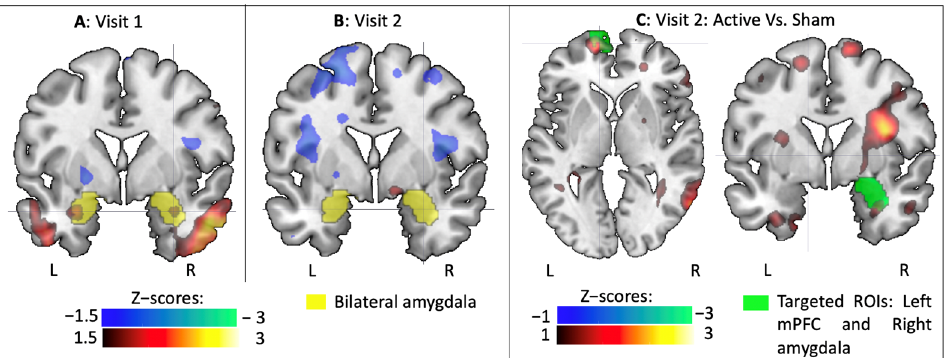
Figure 4. BOLD signal analysis with for the Fear versus Other contrast on Visit 1 ( A ), Visit 2 ( B ), and comparison of the effects of Active versus Sham rTMS on the second visit ( C ). Heat maps indicate Z-scores, blue colors indicate a decrease in BOLD signal and red colors indicate increase. Yellow shading represents the amygdala; and green shading represents masks used to define left mPFC and right amygdala.